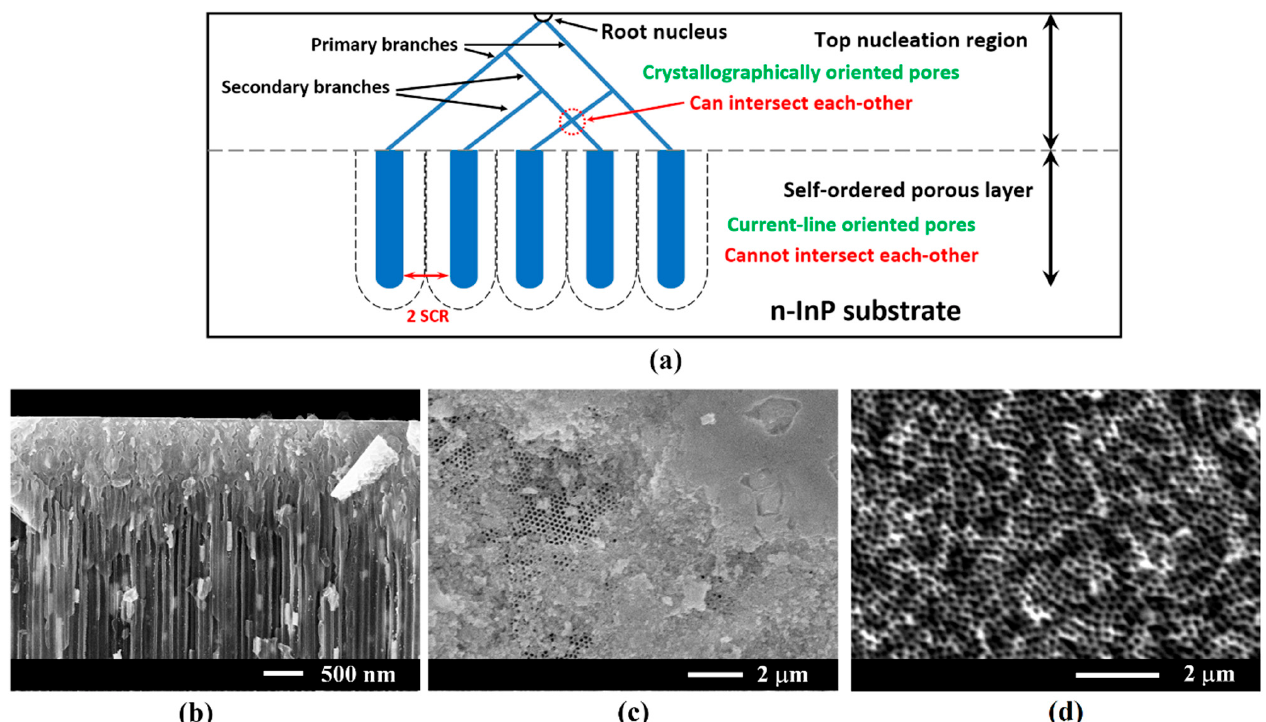
Figure 2. ( a ) Schematic representation of self-ordered porous layer formation; ( b ) cross-sectional SEM image of deposited segmented Pt nanotubes in porous InP template with a top nucleation layer (U = − 16 V; t on = 100 μ s; t off = 1 s); ( c ) top view SEM images after removal of the top nucleation layer by wet chemical etching in HCl:H 3 PO 4 (1:1) during 10 s; ( d ) the same for etching during 25 s.